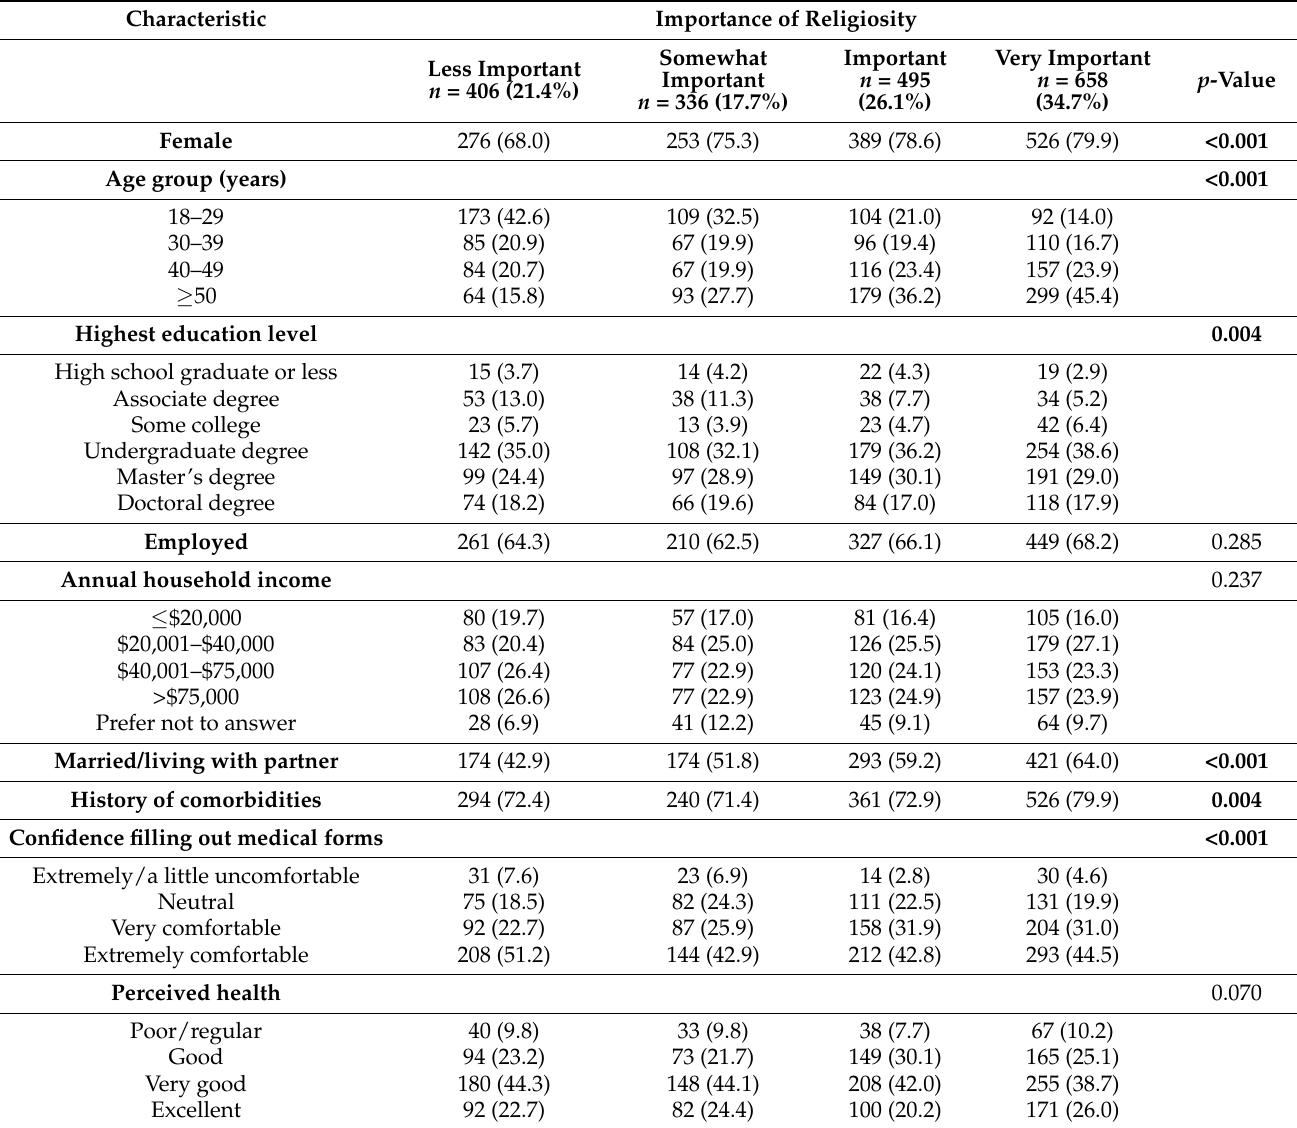
Table 1. Sample characteristics by importance of religiosity among adults living in Puerto Rico ( n =